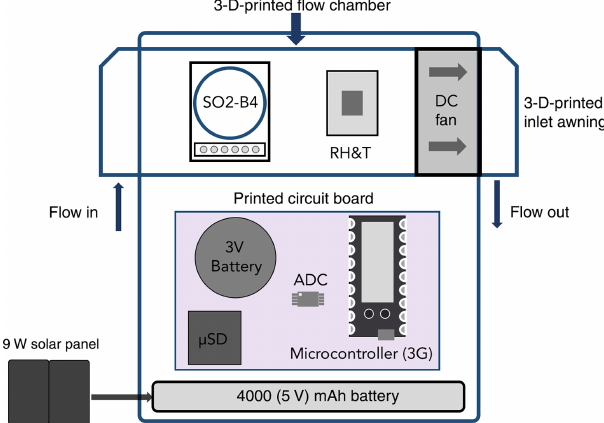
Figure 2. Primary components of the custom sensor node used in this work. Each node includes an Alphasense SO2-B4 electrochem- ical sensor and a RHT sensor embedded in a flow cell with ac- tive flow provided by a DC computer fan. Power is provided by a 9W solar panel coupled to a 4000mAh battery and communi- cates with the remote server via the 3G network. Dimensions are 20cm (L) × 16cm (W) × 11cm